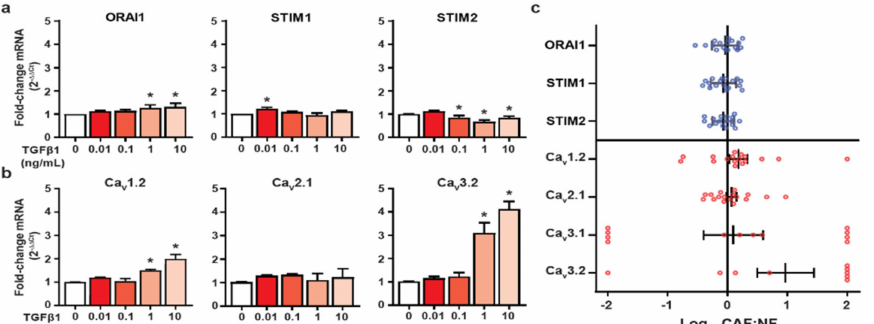
Figure 3. Calcium channels and channel regulators are differentially expressed in CAFs. ( a , b ) Serum starved HMF3S cells were stimulated with either TGF β 1 (0.01, 0.1, 1, or 10 ng/mL) or vehicle control (0 ng/mL) for 48 h prior to RNA isolation. mRNA levels of SOCE channels and channel regulators; ( a ) Orai1, stromal interaction molecule 1 and 2 (STIM1, and STIM2) and ( b ) voltage-gated calcium channels (VGCCs); Ca V 1.2, Ca V 2.1, Ca V 3.2, were assessed using quantitative RT-PCR. Values are expressed as fold change relative to vehicle control. Data are represented as mean ± SD from three independent experiments; * p < 0.05 from post-hoc Dunnett’s multiple comparison test after one-way ANOVA revealed significant effect of treatments. ( c ) Ratio of mRNA of selected calcium channels and channel regulators in paired patient CAFs and normal breast fibroblasts (NFs). Values ± 2 indicate mRNA was not detected in either the CAF or NF